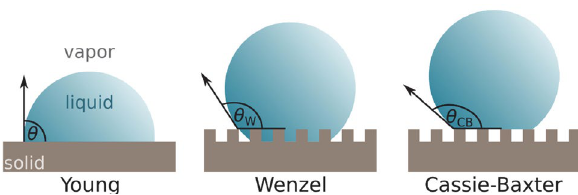
Figure 16. Schematic presentation of different wetting models: Young model on flat surface, and Wenzel and Cassie-Baxter models on rough surfaces. θ is contact angle of liquid